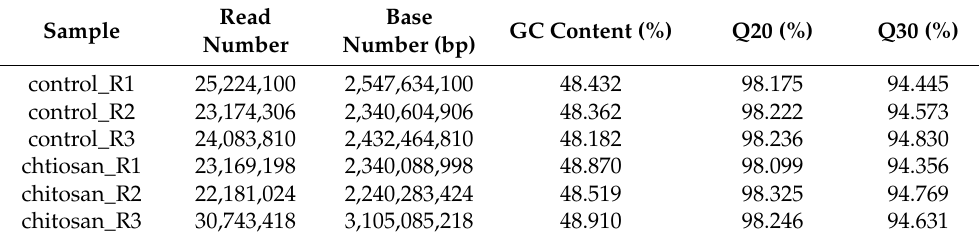
Table 2. Summary of RNA-sequencing (RNA-seq) raw data. A total of six libraries were generated from Microsorum scolopendria untreated (three samples) and treated with chitosan (three samples). For each condition, three different libraries were paired-end sequenced using NovaSeq 6000 system. Raw sequence data were deposited in NCBI’s SRA database with the respective accession